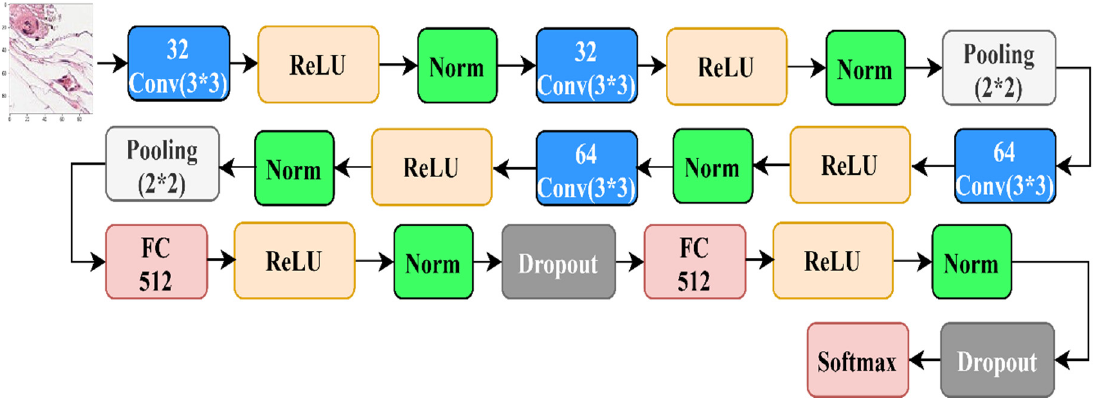
Figure 7. The architecture of Basha et al. [25].